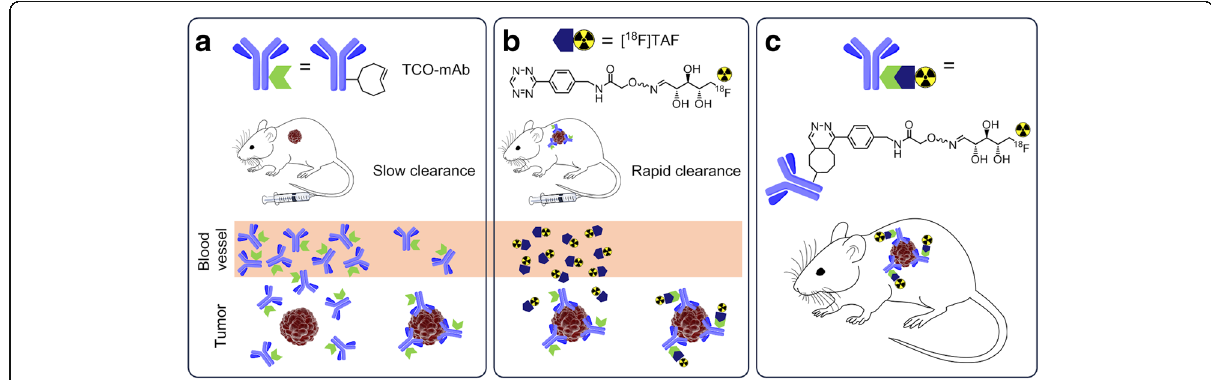
Fig. 1 Conceptual representation of a two-step pretargeted method based on IEDDA reaction. The current approach involves the sequential administration of an antibody, followed by administration of a small molecule radiotracer after 24 – 72 h. a TCO-modified antibody is administered first. It circulates for a couple of days and eventually accumulates in the tumour and clears from the blood pool and other non-target tissues. b After a predetermined lag time, a radiolabelled tetrazine tracer is administered. It reacts selectively with the TCO group attached to the antibody and the unreacted tracer clears rapidly from the blood. In this work, the used radiotracer was 18 F-labelled tetrazine, [ 18 F]TAF. c The antibody can now be localized via the radiolabel on the tracer. The pretargeting approach with short-lived tracer significantly lowers the radiation burden to the subject compared to traditional methods where the antibody is directly radiolabelled with a longer-lived